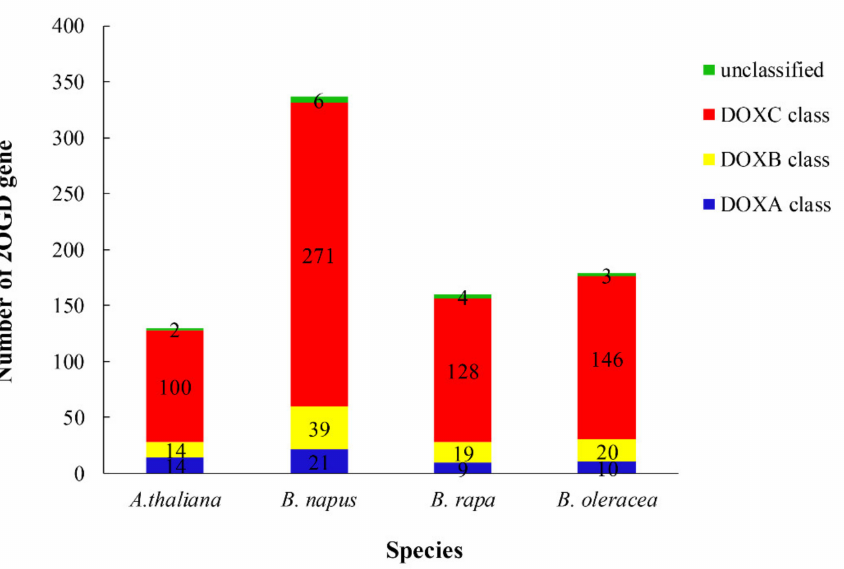
Figure 4. Compositional differences in the 2OGD classes in Brassica species and A. thaliana . The number of 2OGD genes in the DOXA, DOXB, and DOXC classes is represented by different colours; ‘unclassified’ represents 2OGD genes that belong to none of the